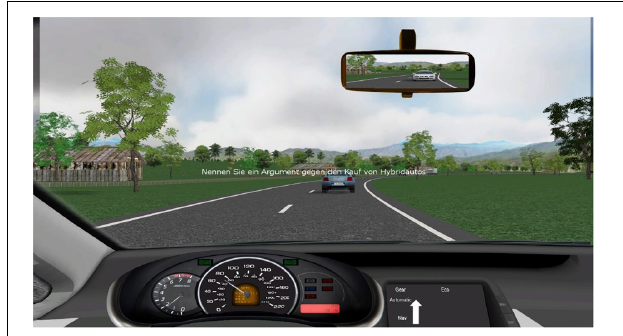
FIGURE 3 | Screenshot out of the cockpit with visually displayed reasoning task.